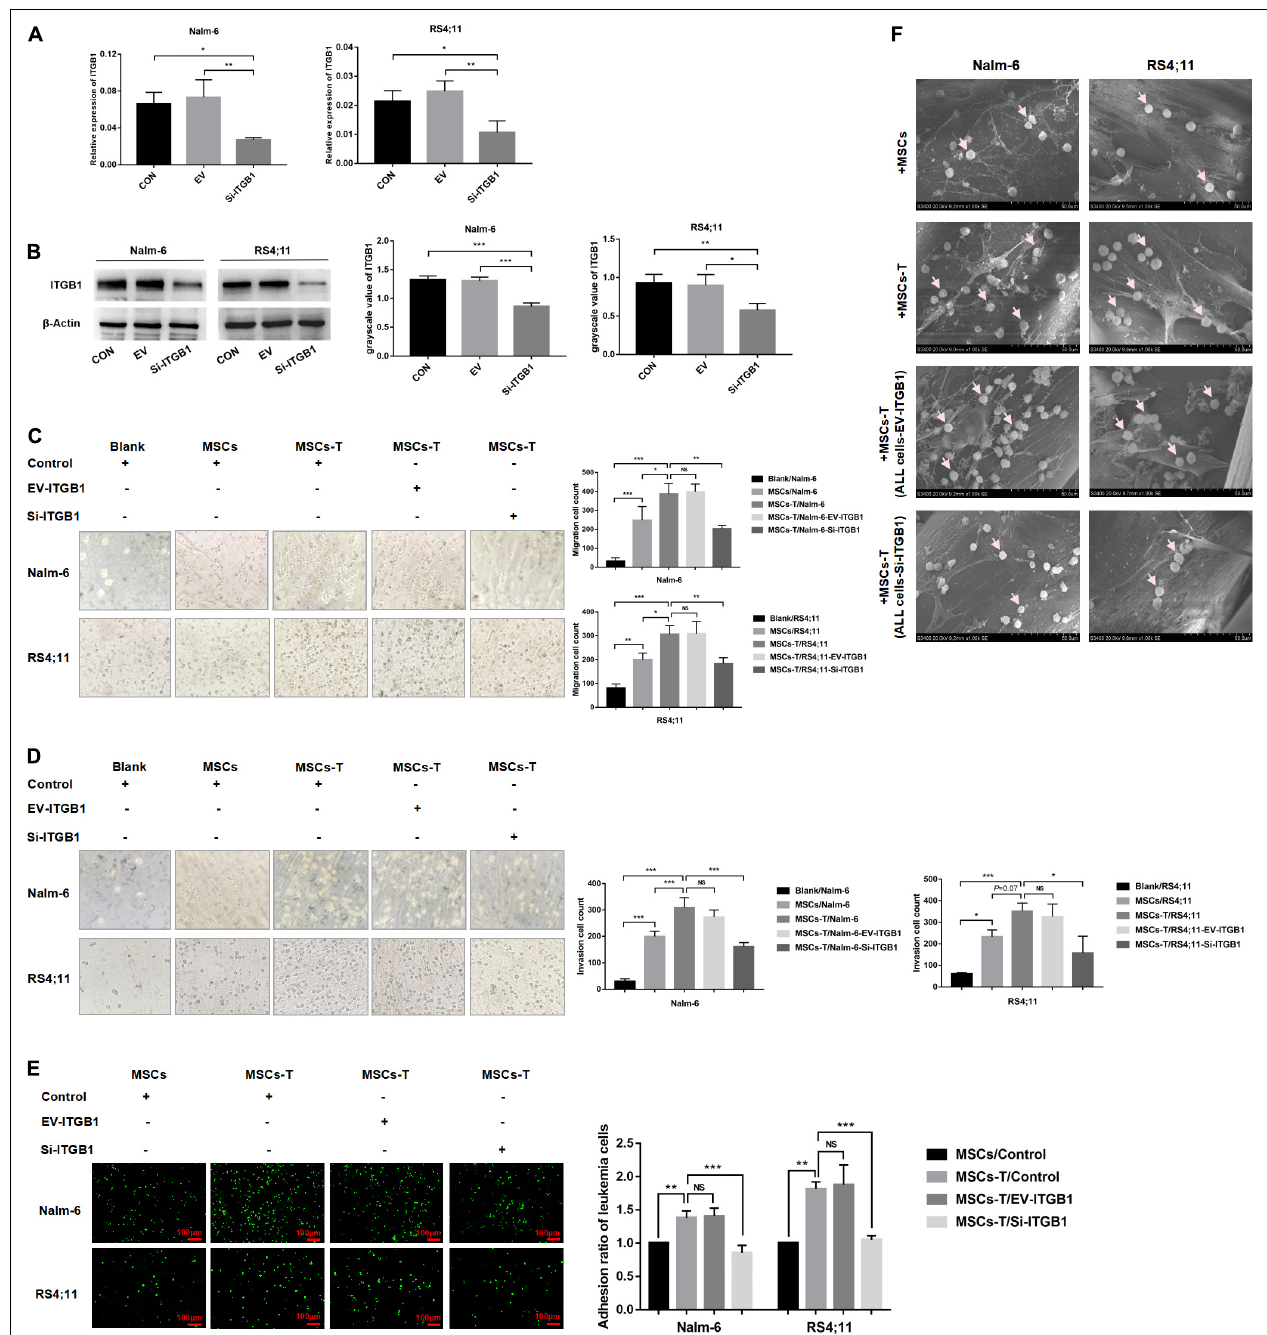
FIGURE 7 | Down-regulating the ITGB1 in leukemia cells could effectively weaken the interaction between leukemia cells and MSCs with CAF-like phenotype. (A,B) The mRNA and protein expression levels of ITGB1 in Nalm-6 and RS4;11 cell lines were measured by RT-PCR and western blot after transfection with EV and si-ITGB1 recombinant lentiviral. (C,D) Transwell chamber test to detect the number of Nalm-6 and RS4;11 cells migration and invasion in blank, MSCs, TGF- β conditioned MSCs, TGF- β conditioned MSCs/EV-ITGB1 and TGF- β conditioned MSCs/Si-ITGB1 group after 24 h of cells incubation. (E) Fluorescence quantitative method detected the adhesion of leukemia cells to stromal cells when Nalm-6/RS4;11 cells were co-cultured with MSCs, TGF- β conditioned MSCs, TGF- β conditioned MSCs/EV-ITGB1 and TGF- β conditioned MSCs/Si-ITGB1 group for 24 h (100 × , scale bars, 100 µ m). (F) The adhesion of leukemia cells to stromal cells when Nalm-6/RS4;11 cells were co-cultured with MSCs, TGF- β conditioned MSCs, TGF- β conditioned MSCs/EV-ITGB1 and TGF- β conditioned MSCs/Si-ITGB1 in a 3D scaffold for 24 h (1000 × ). Each value indicates the mean ± SD of three or more independent experiments. In each independent repeated experiment, MSCs was isolated and cultured from a B-ALL patient, and stimulated with rhTGF- β to obtain the CAF-like phenotype, then the latter were compared with the untreated MSCs from the same patient to ensure that the experiment was comparable. * P < 0.05, ** P < 0.01, *** P < 0.001.